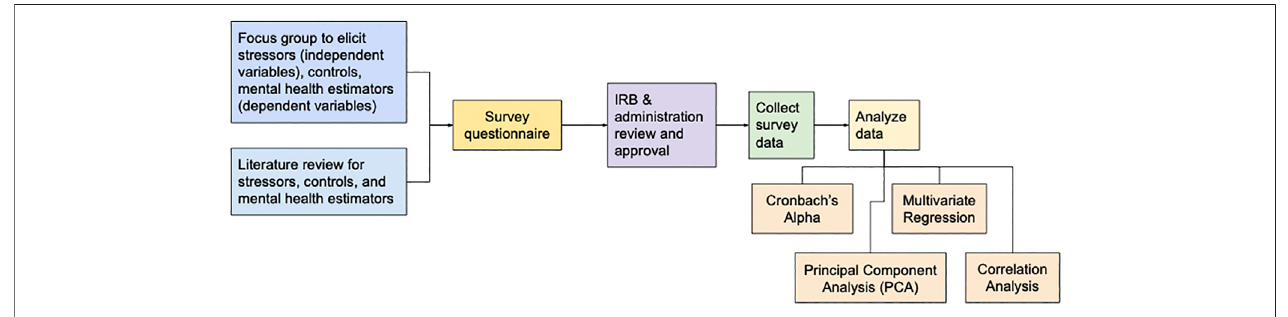
FIGURE 1 | Overview of the methods used in this study.